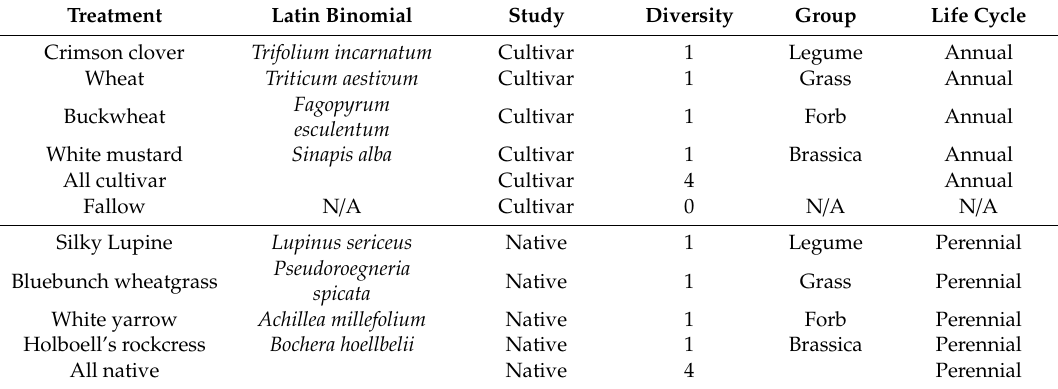
Table 1. Selected cover crops for native study and cultivar study greenhouse experiments. Native plants were collected in the Okanagan Valley, while seeds of cultivar plants were purchased from seed suppliers. N / A = not